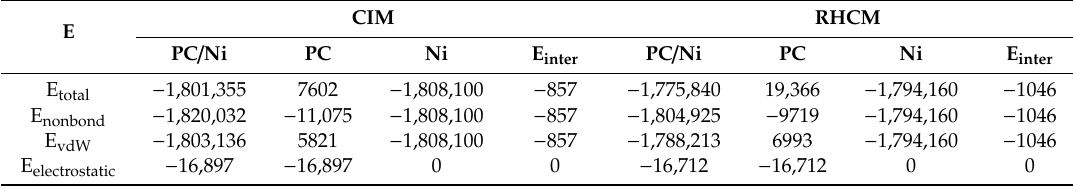
Table 1. Energy between long-chain PC and the nickel mold insert at the end of the filling stage (kJ·mol − 1 ).